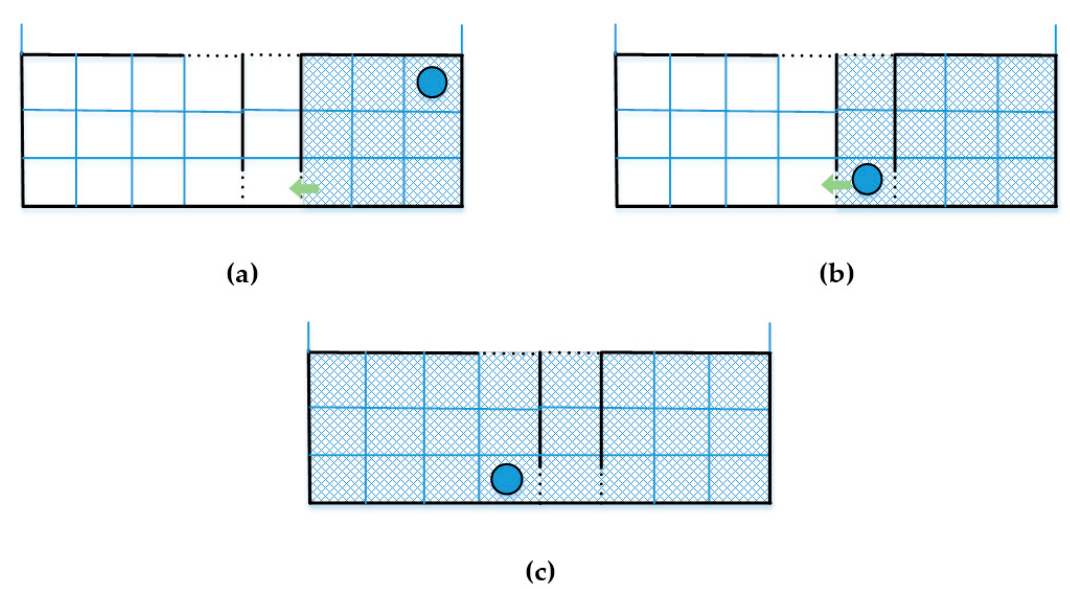
Figure 6. Memory expansion process during exploration: ( a ) agent has gained knowledge about 9 nodes; ( b ) agent changed its position and added 3 more nodes to memory; ( c ) agent has moved to another room and added 12 more nodes to its memory, expanding initial memory to 24